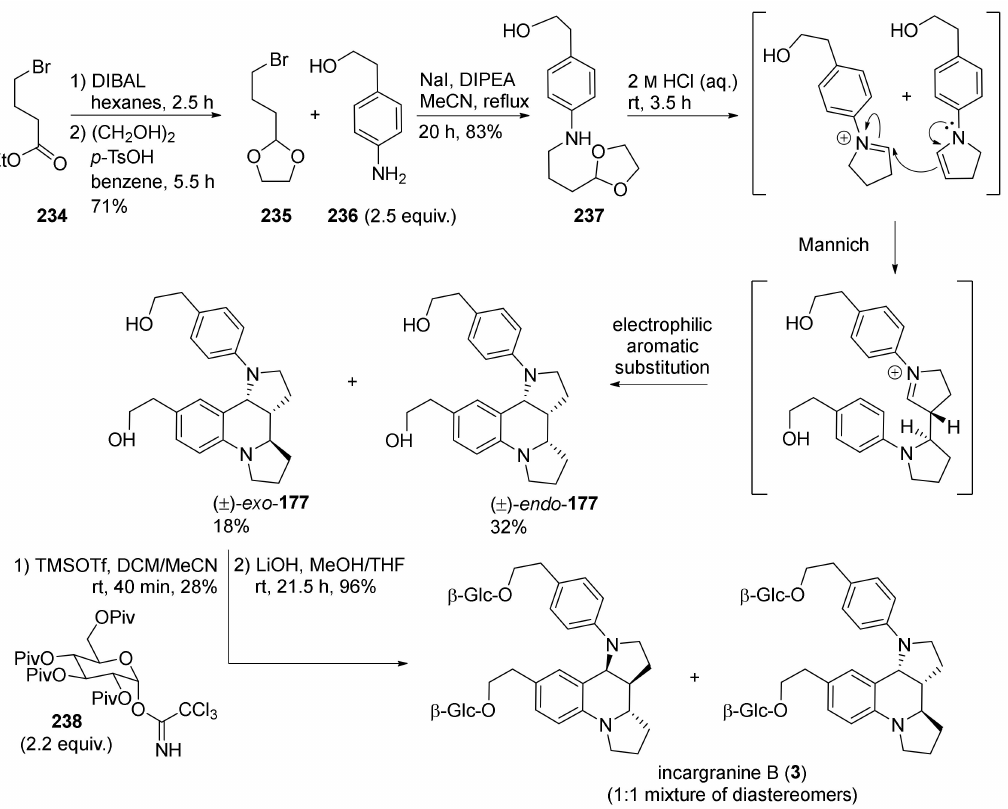
Scheme 38. Synthesis of Incargranine B completed in the Lawrence group.